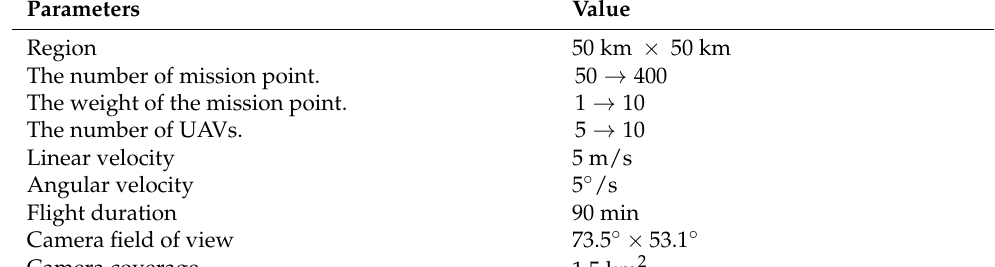
Table 3. Simulation experiment parameter setting table.